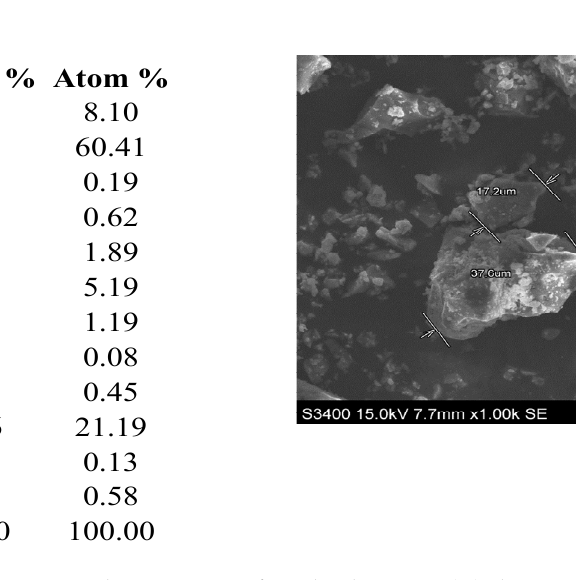
Figure 1. Characteristics of Portland cement: ( A ) elemental analysis, ( B ) SEM image ( × 1000) with dimensions of individual grains.